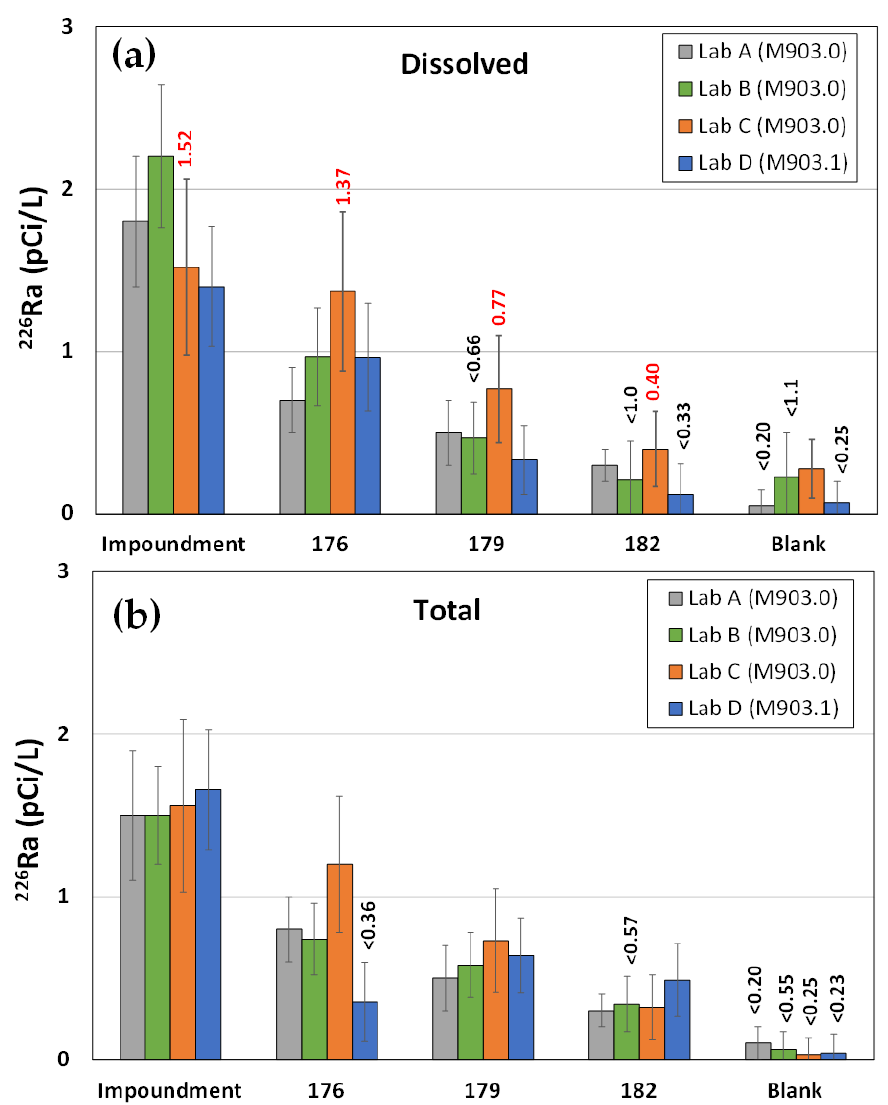
Figure 3. Comparison of ( a ) Dissolved 226 Ra; ( b ) Total 226 Ra. Values in red are qualified as estimated with high bias (J+) when sample result contained <10× the amount measured in the field blank. Values in black signify the MDC when the reported value is less than the MDC.